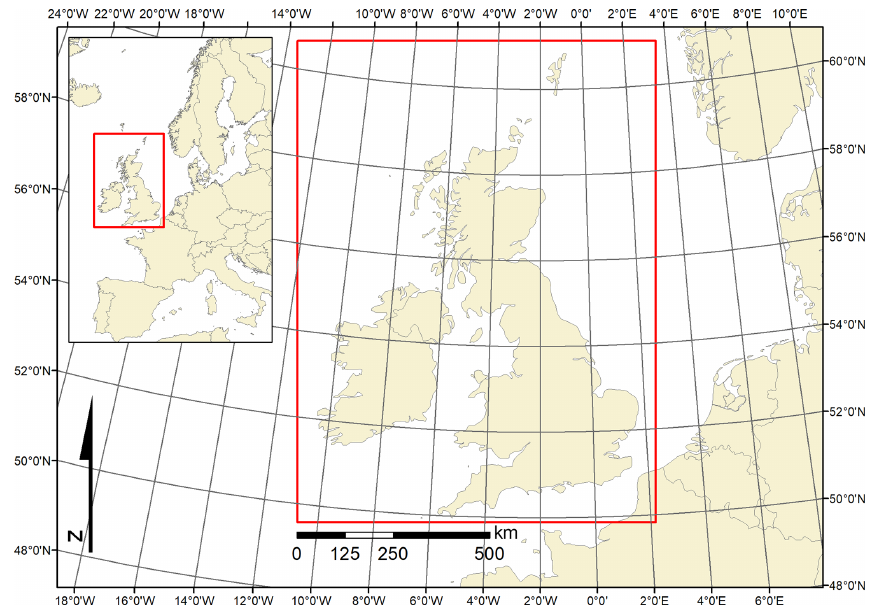
Figure 1. The UK FRAME modelling domain, shown by a red rectangle, within which 1km × 1km estimates of N deposition are made. The inset shows the context within Europe and lines of latitude and longitude are also shown, while the inputs and outputs of the model are in the British National Grid projected coordinate